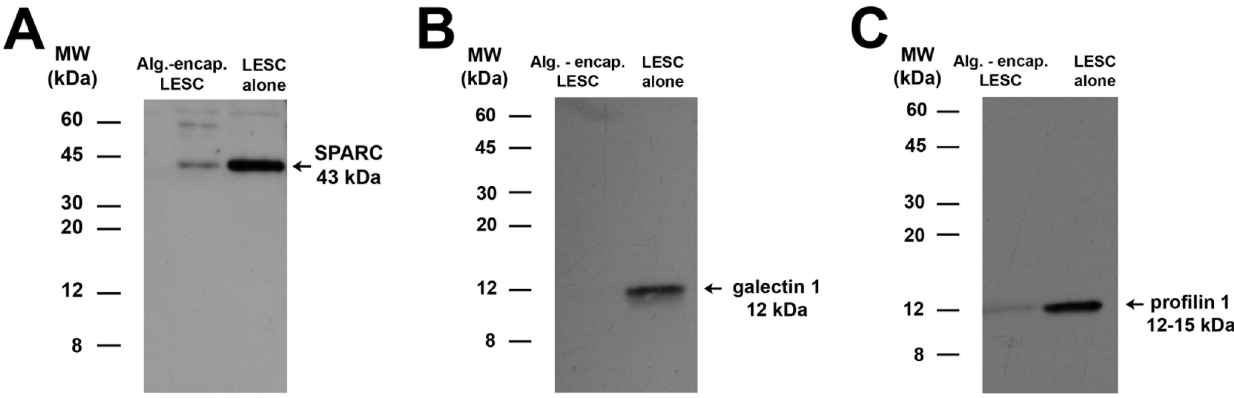
Figure 5. Proteins known to modulate cell proliferation are identified within the LESC secretome. SPARC (A), galectin 1 (B), and profilin 1 (C) were detected in conditioned medium from alginate-encapsulated LESC (CM ALG-LESC ) and LESC (CM LESC ) cultured in CnT20 for 3 days under cell culture conditions by immunoblotting. Blots represent 3 individual experiments from 3 different corneoscleral rims.